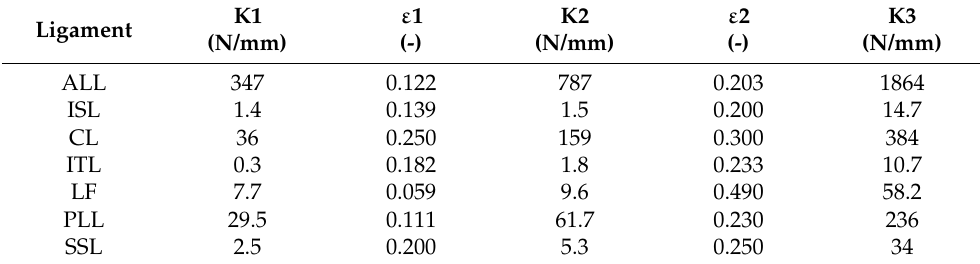
Table A2. Number, connection type, and length of elements in the ligaments